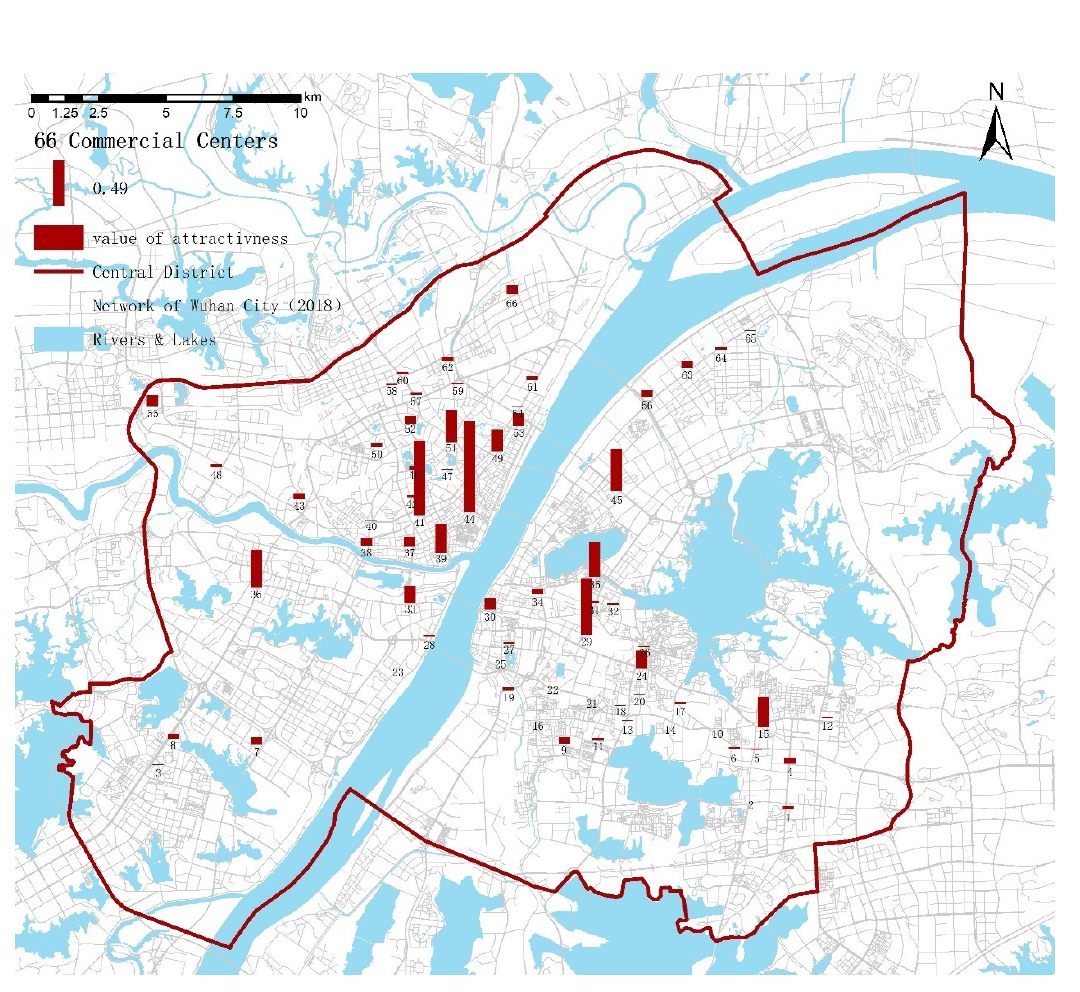
Figure 5. Value of attractiveness of 66 commercial centers.